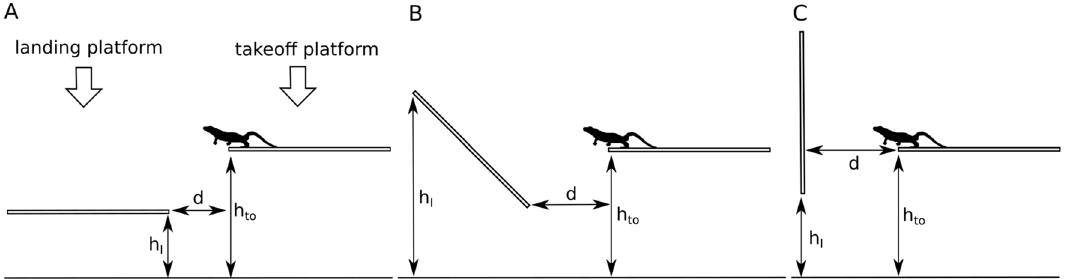
Figure 1. Setup for jumping experiments with landing platforms of different inclines. ( A ) A gecko jumping onto a lower horizontal platform. ( B ) A gecko jumping onto an inclined platform (45°). ( C ) A gecko jumping onto a vertical platform. Drawings are not scaled. Constructions that hold the take-off and landing platform are not shown. d: distance between platforms; h l : height of the landing platform; h to : height of the take-off